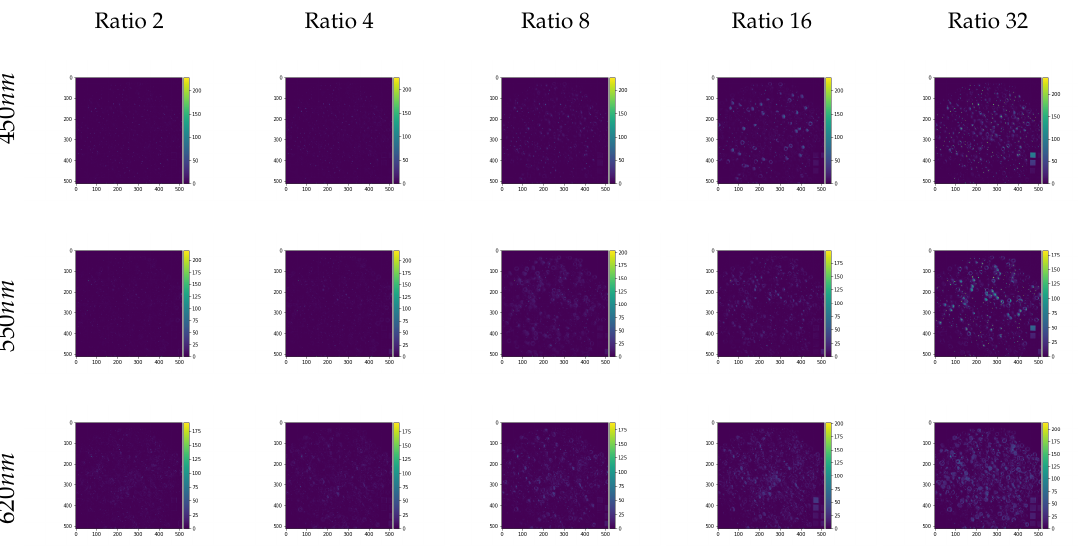
Figure 7. Image differences between the generated images and the original multispectral bands for the beads image on the CAVE dataset. The bands shown are equivalent to the work of [22].